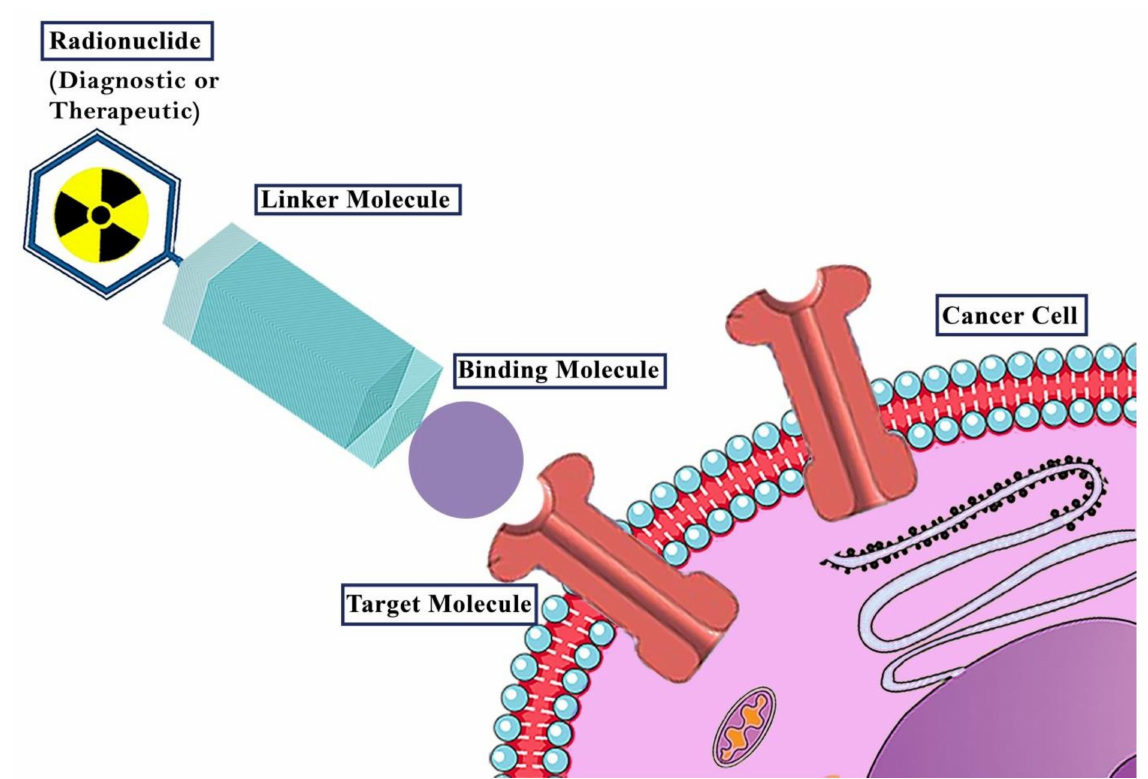
Figure 1. The general concept of theranostic radiopharmaceuticals. A radionuclide is combined with a targeting vector (Binding molecule). The choice of radionuclide defines the purpose of the radiopharmaceutical. γ − or β + -emitters are used for diagnostics while β − - and α -emitters are applied in therapy. The targeting vector guides the radiopharmaceutical to its specific target (e.g., receptors). To combine the radionuclide with a target vector without reducing its affinity to its target, normally, depending on the type of radionuclide (e.g., metal, non-metal), linking structures (linker molecules) are